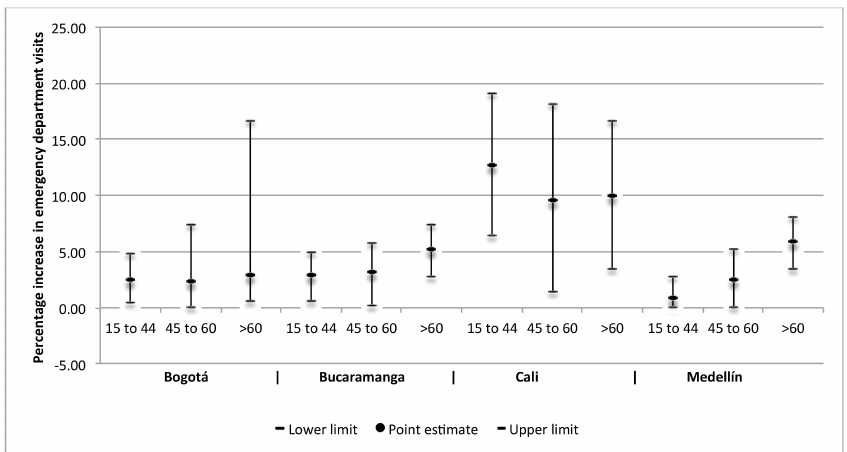
Figure 1. Percentage increases in emergency department visits by children for respiratory diseases associated with PM 2.5 concentrations, per age group, in the four cities in Colombia, 2011–2014. Point estimates and 95% confidence intervals for age groups of children in years.